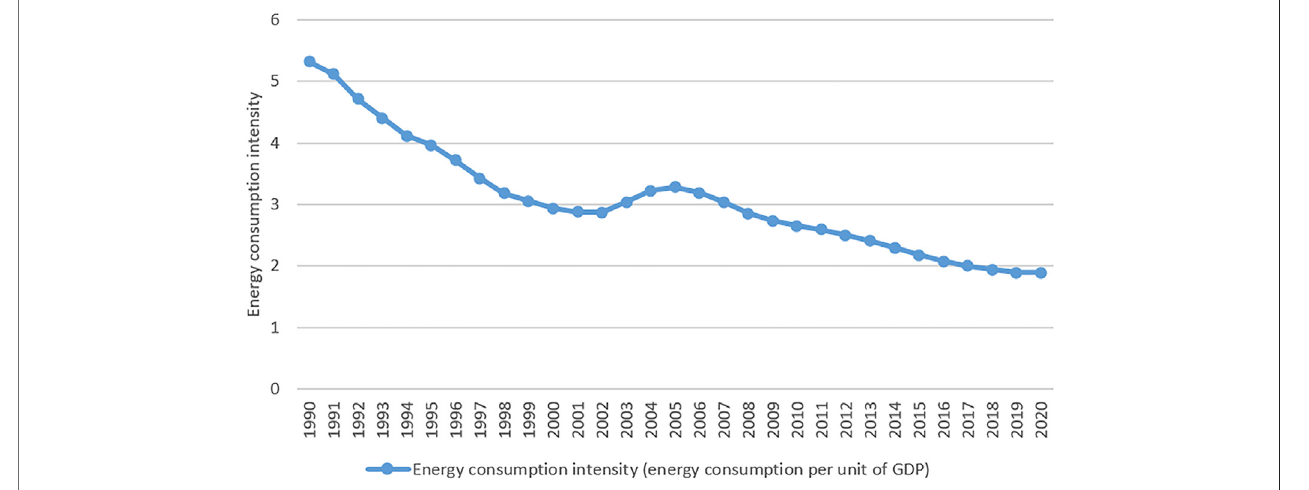
FIGURE 6 | change of China ’ s energy consumption intensity from 1990 to 2020. Data source: China Statistical Yearbook